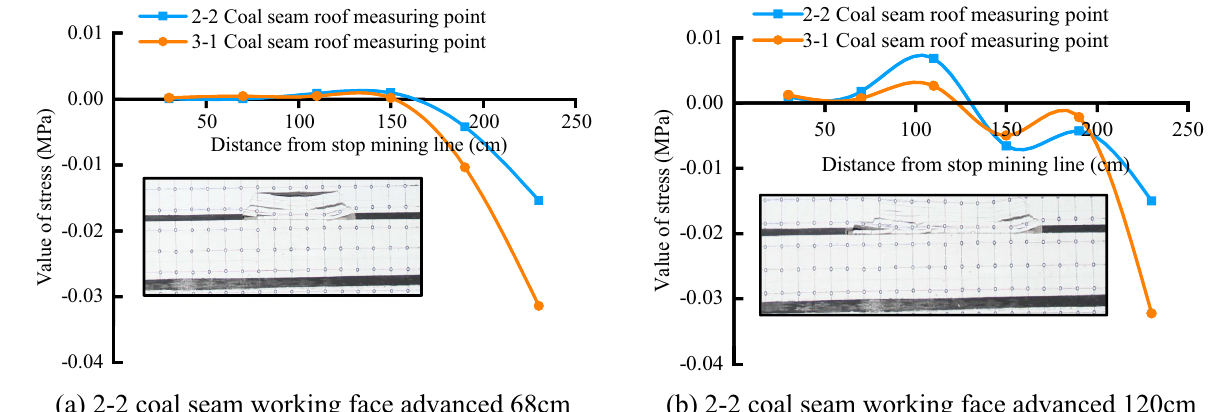
Figure 3. Stress distribution of 2–2 coal seam mining.